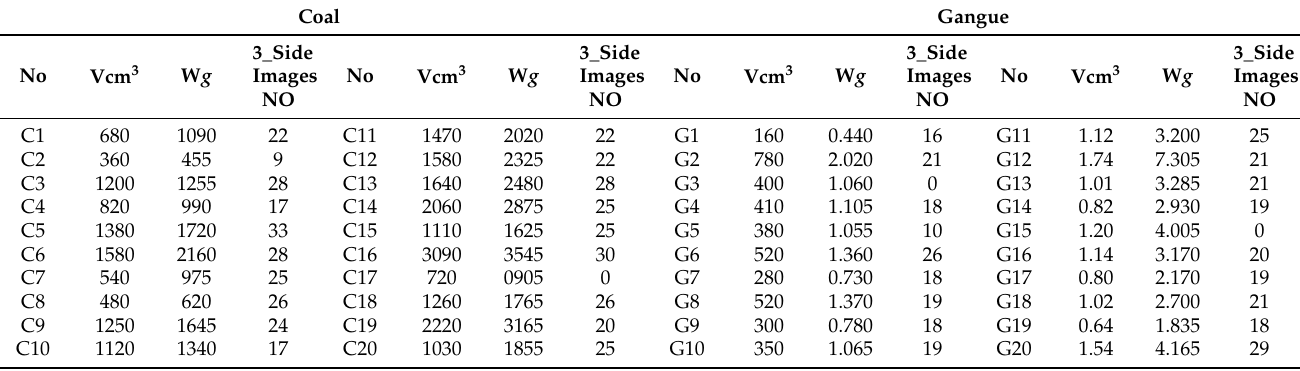
Figure 2. Capturing Stand Prototype with three USB cameras positions in three sides Top_Side, Front_Side and Left_Side, coal gangue sample, and the Acquisition Interface. Table 1. Volume in cm 3 and Weight in g real measurements for coal and gangue using physical methods with 3_side